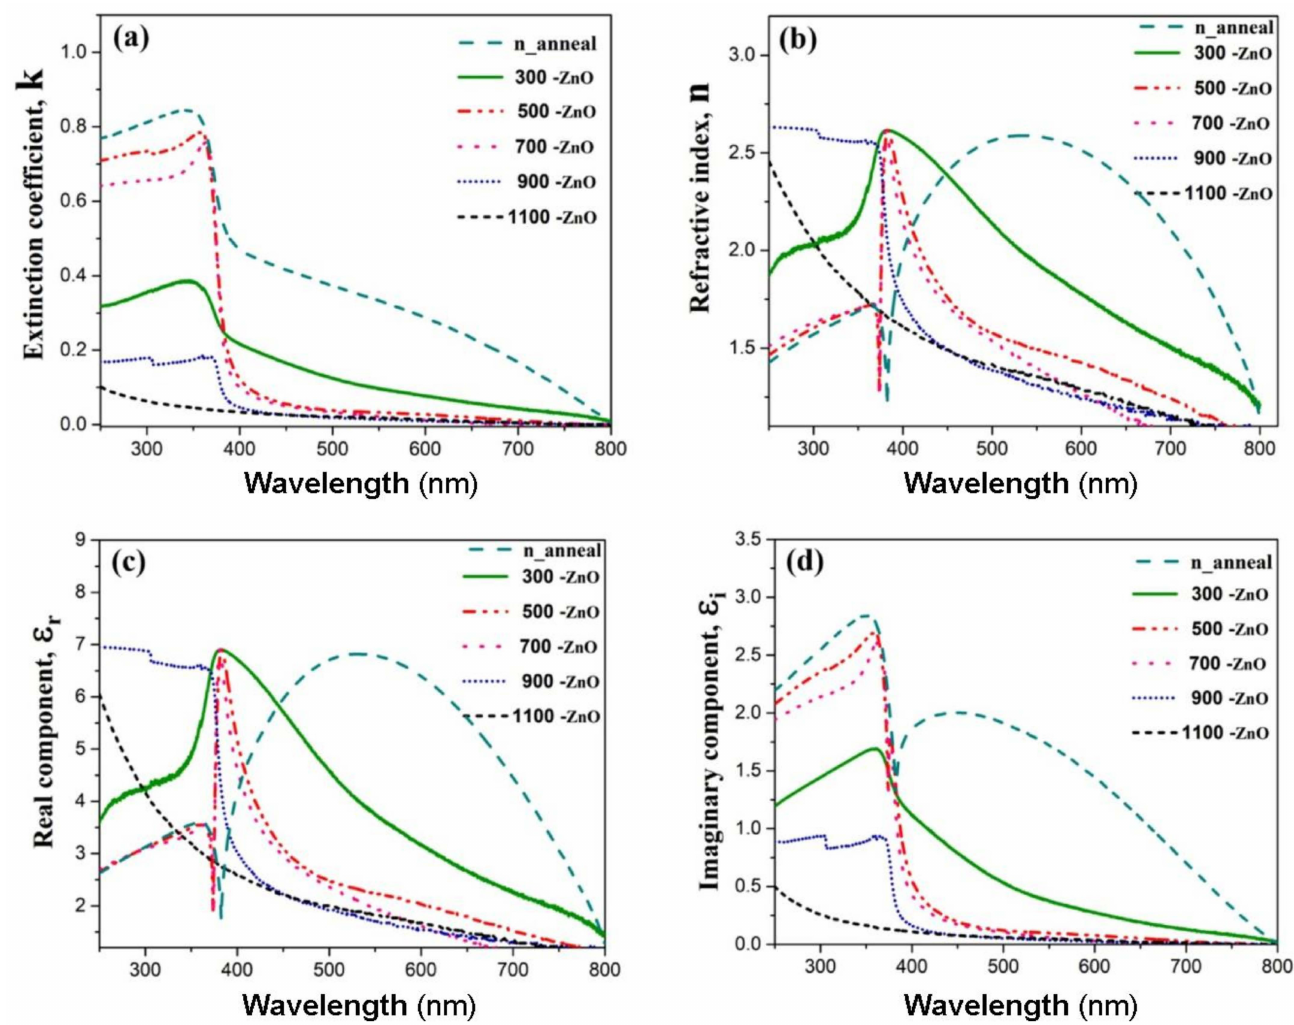
Figure 13. The extinction coefficient ( a ) refractive index ( b ) and real ( c ) and imaginary ( d ) portions of complex dielectric function of the thin films